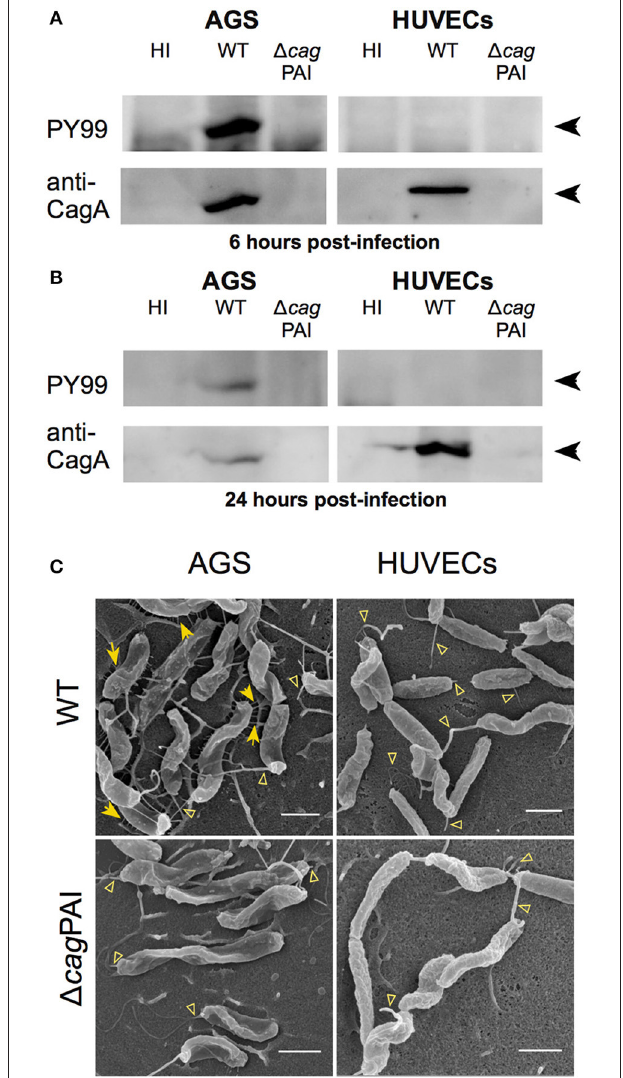
FIGURE 4 | Interaction of H. pylori with HUVECs does not result in CagA translocation or formation of cag PAI-dependent pili. Analysis of CagA translocation upon (A) 6 hpi or (B) 24 hpi infection of AGS or HUVECs with H. pylori P12 WT or isogenic 1 cagPAI mutant; MOI = 30. Infected-cell lysates were analyzed by western blot using antibody PY99 to detect tyrosyl-phosphorylated CagA. Blots were stripped and re-probed with CagA-specific antibody to determine the total amounts of CagA. Black arrowheads indicate CagA or tyrosine phosphorylated CagA bands. (C) AGS or HUVECs were infected with H. pylori WT or 1 cagPAI mutant at MOI of 30. Samples were fixed at 4 hpi and then subjected to FESEM. Yellow arrows indicate cag PAI-dependent pili-like structures; open arrowheads indicate flagella, including intact flagella and remnants of broken sheathed or unsheathed flagella. Scale bars, 1 µ